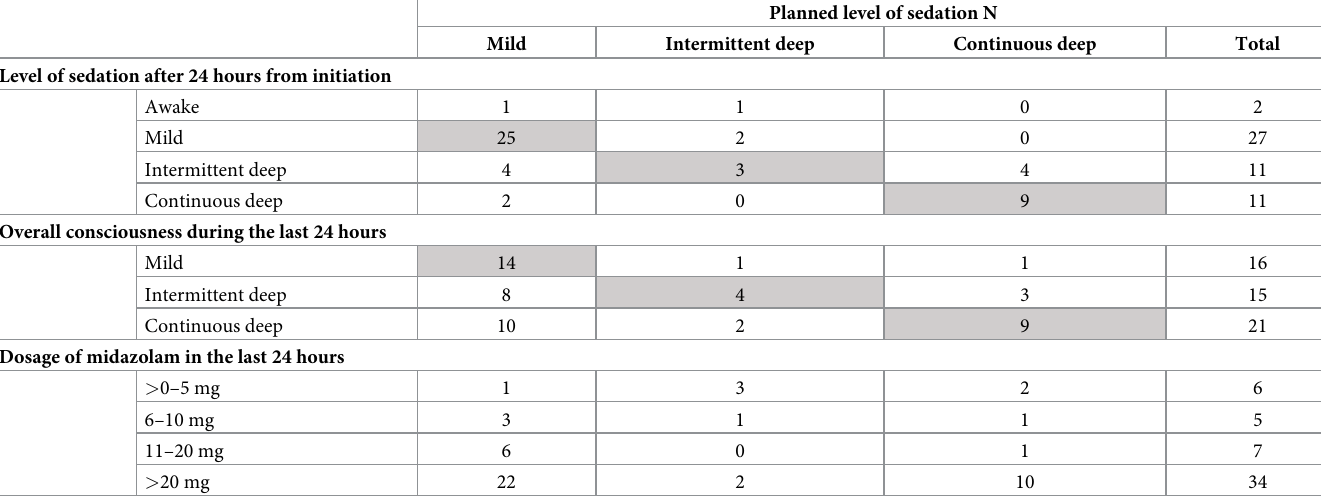
Table 2. Level of sedation/consciousness during the dying phase, as compared to the planned level of sedation, for patients with decision to sedate. The correspon- dence between the planned level and the achieved level (marked in grey) was 73% for level of sedation after the first 24 hours from initiation and 52% for overall conscious- ness in the last 24 hours .